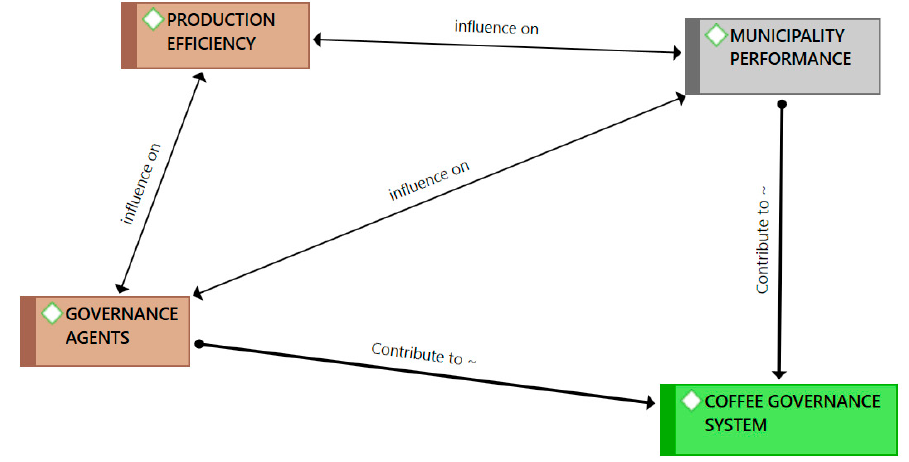
Figure 1. TG model associated with coffee production. The author.